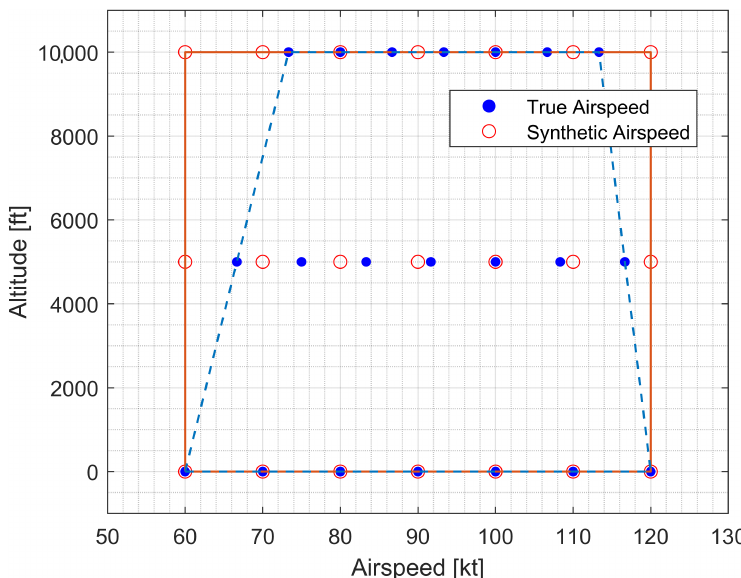
Figure 6. Rectangular scheduling parameter